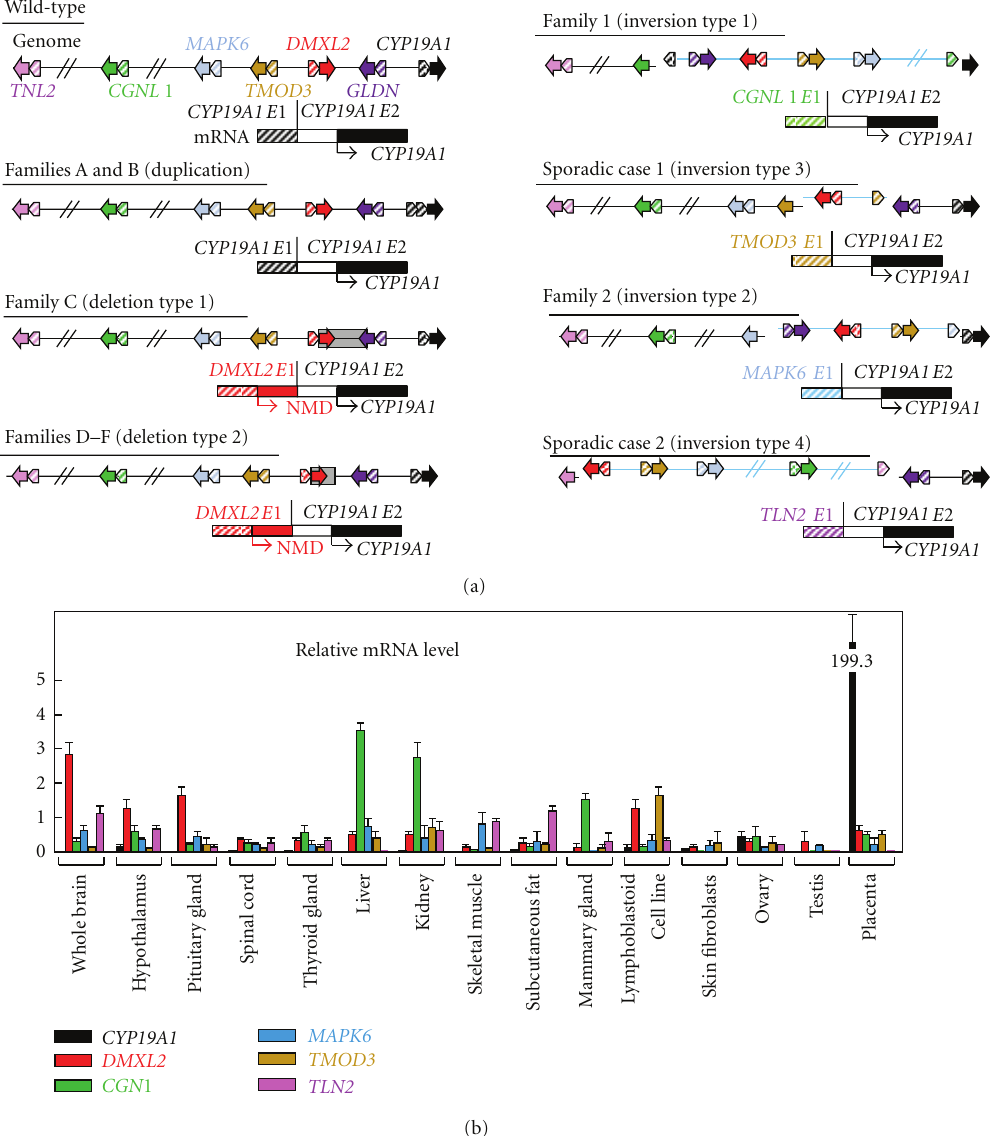
Figure 3: Structural and functional properties of the fused exons. (a) Schematic representation of the rearranged genome and mRNA structures. The white and the black boxes of CYP19A1 exon 2 show untranslated region and coding region, respectively. For genome, the striped and the painted arrows indicate noncoding and coding exons, respectively (5 (cid:3) → 3 (cid:3) ). The inverted genomic regions are delineated in blue lines. For mRNA, colored striped boxes represent noncoding regions of each gene. The DMXL2-CYP19A1 chimeric mRNA has two translation initiation codons and therefore is destined to produce not only CYP19A1 protein but also a 47 amino acid protein which is predicted to undergo nonsense-mediated mRNA decay (NMD). The deletion and the inversion types are associated with heterozygous impairment of neighboring genes (deletion or disconnection between noncoding exon(s) and the following coding exons). The inversion subtype 1 is accompanied by inversion of eight of the 11 CYP19A1 exons 1, and the inversion subtype 2 is associated with inversion of the placenta-specific CYP19A1 exon I.1. (b) Expression patterns of CYP19A1 and the five neighboring genes involved in the chimeric gene formation [4]. Relative mRNA levels against TBP in normal human tissues are